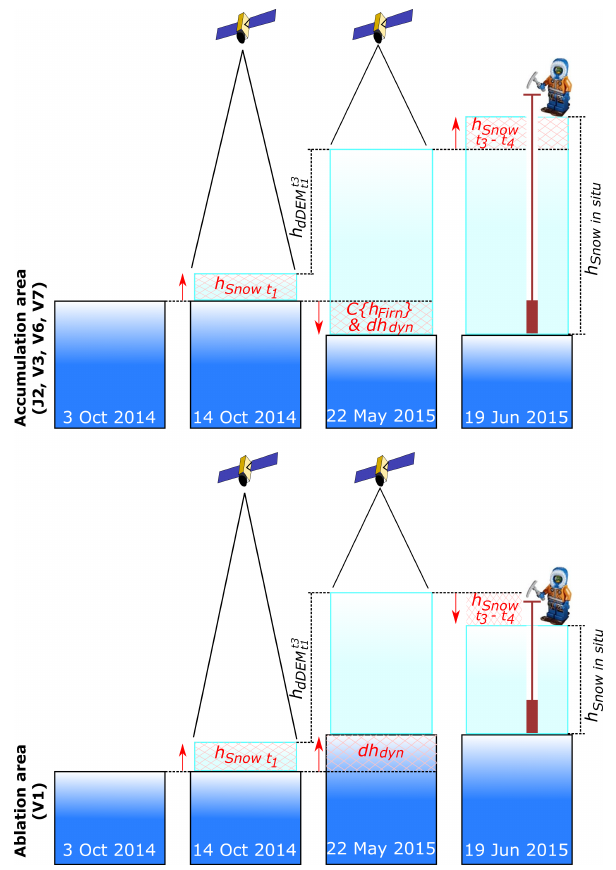
Figure 6. Sketch of the different factors, marked in red and indi- cated with red arrows, affecting the comparison between the glacio- logical (3 October 2014–19 June 2015) and geodetic (14 Octo- ber 2014–22 May 2015) methods. Light blue represents snow fallen in winter, and dark blue represents preexisting ice and